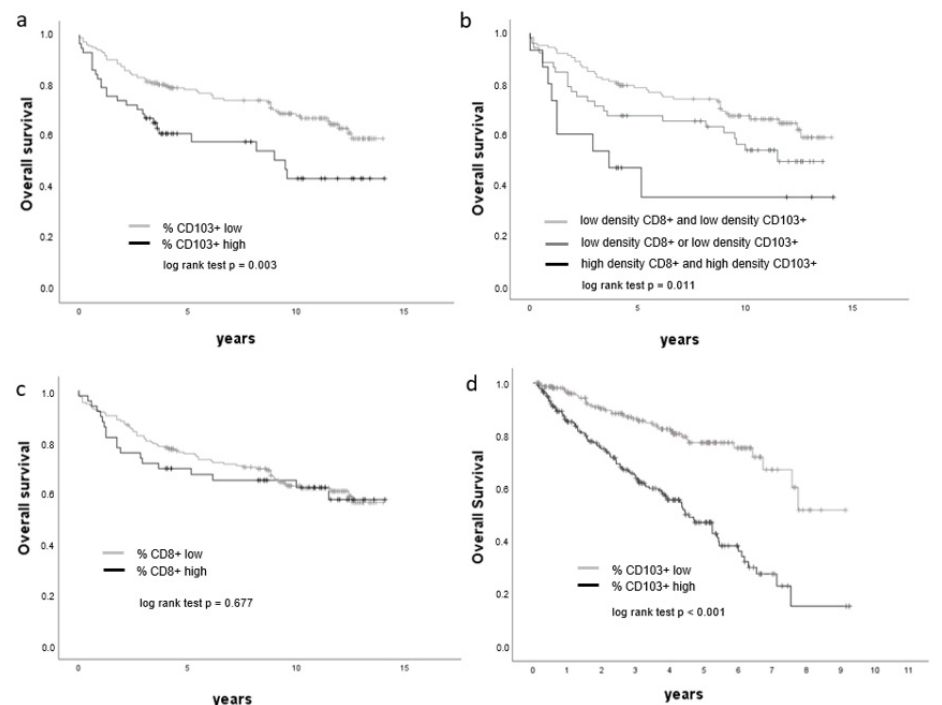
Figure 5. Overall survival is associated with CD103+ lymphocyte density. ( a – d ) Kaplan–Meier curves showing the overall survival of ccRCC patients with respect to cell densities of CD8+, CD103+ and CD103+ CD8+ cells, respectively ( a – c : Berlin cohort, d : TCGA KIRC cohort).